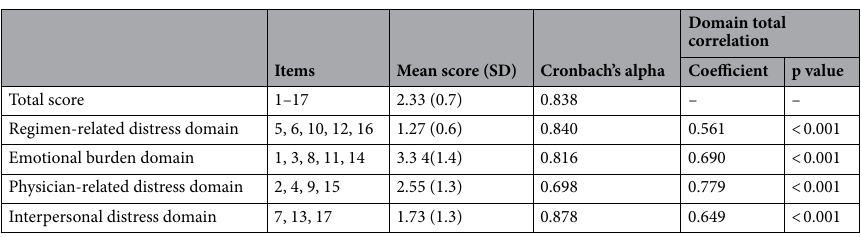
Table 2. Internal consistancy relaibility of BDDS-17 and its domains (n = 1184). Cronbach’s Alpha and its 95% CI of the 17-item scale and of each of the 4 domains are generated. Correlation coefficient and p value for the domain total correlation are presented in the right two